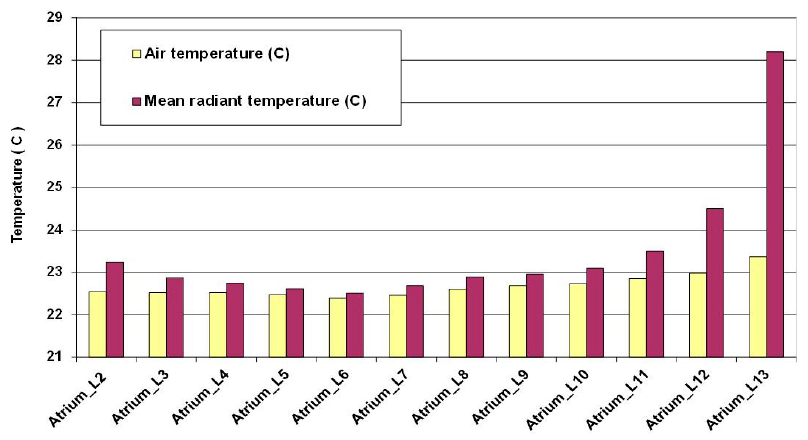
Figure 2. Temperature distribution within the atrium from level 2 (Atrium_L2) till level 13 (Atrium_L13).